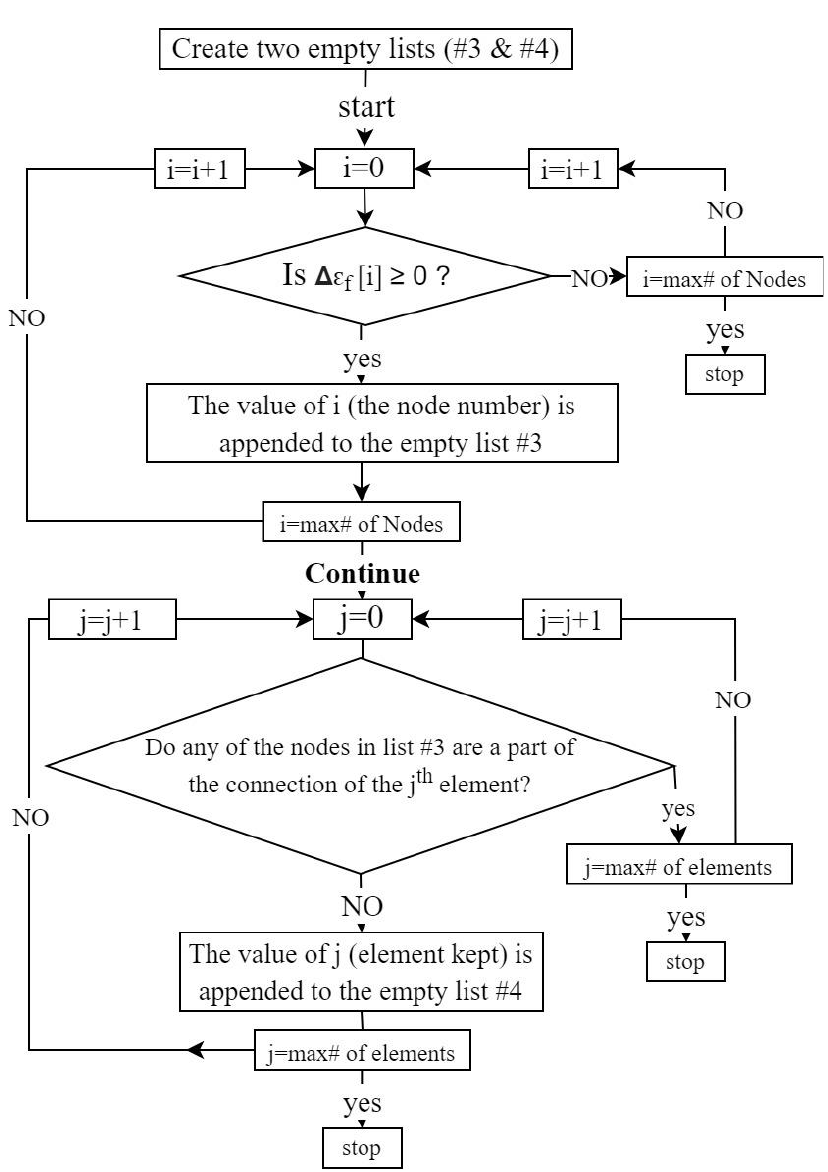
Figure A3. Flow chart describing the element deletion algorithm used to identify the designated numbers of nodes that should be deleted and the elements constituting the new model.